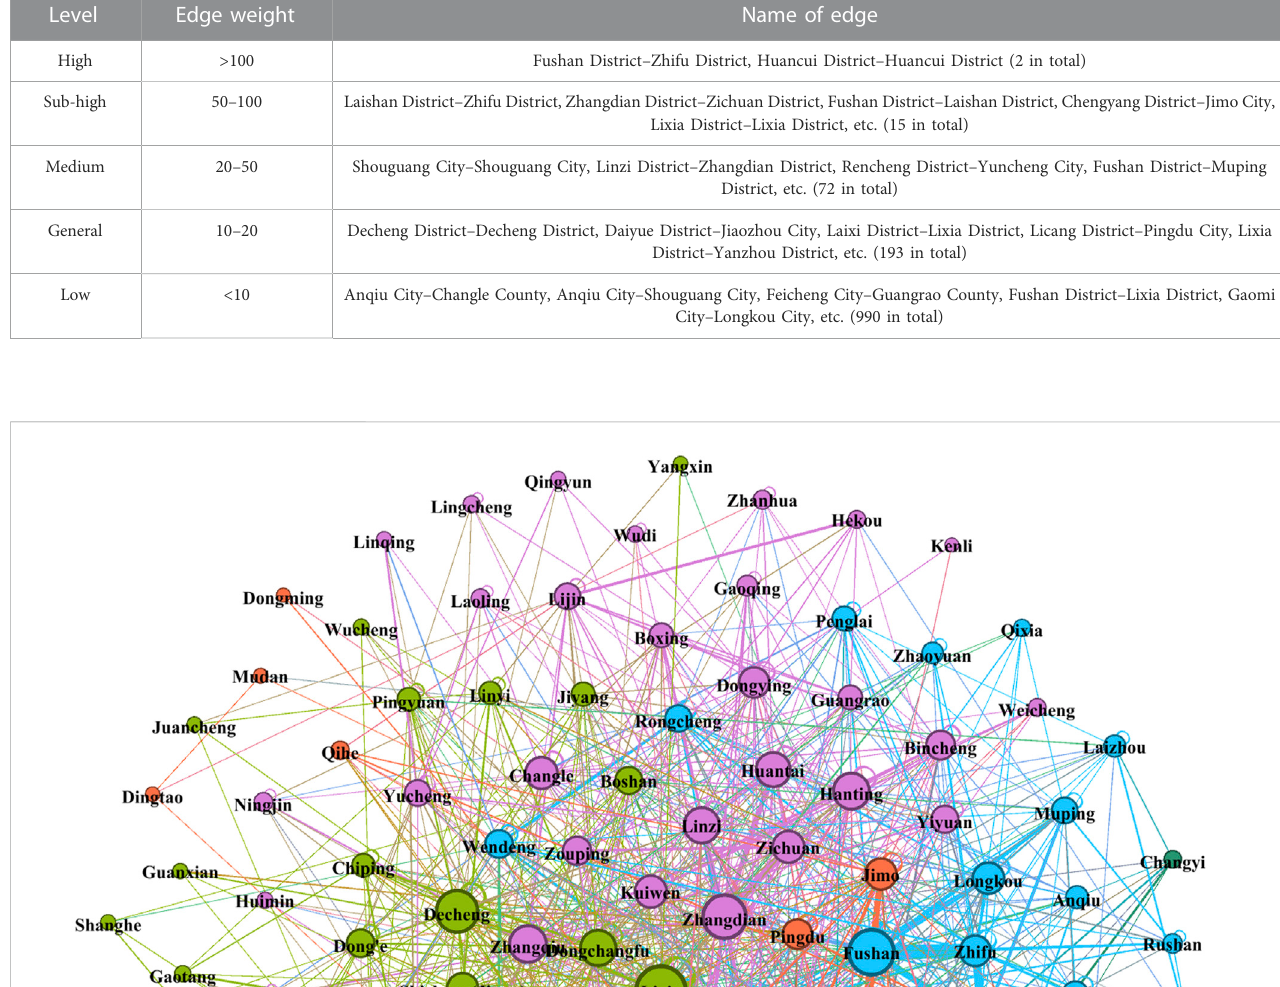
TABLE 4 Edge weights classi fi cation of city supply network in Shandong.